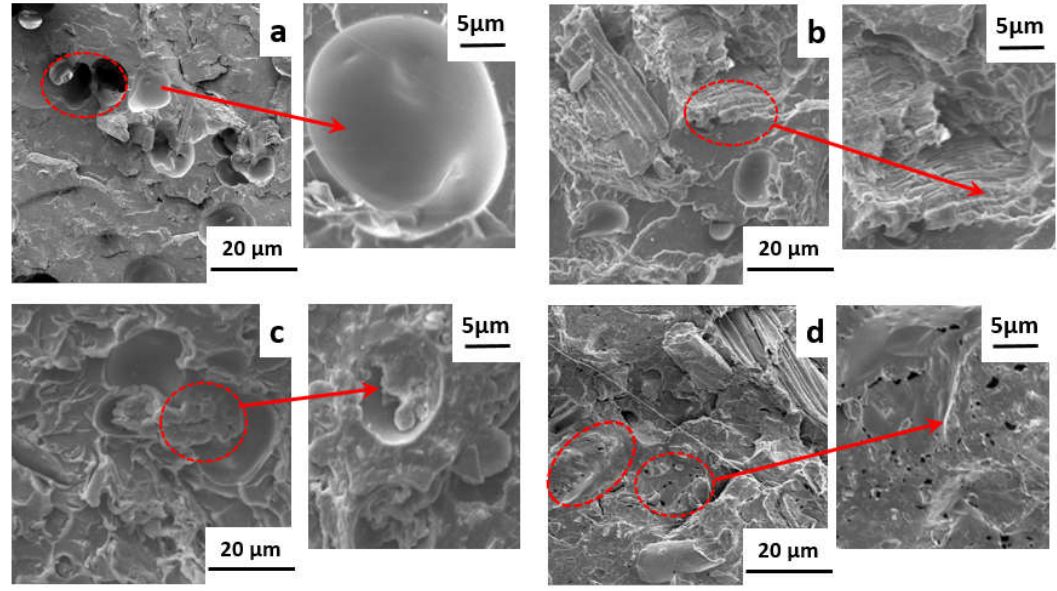
Figure 5. SEM morphology of impact-fracture surface for PLA-based NPCs: ( a ) NPC0; ( b ) NPC1; ( c ) NPC2; ( d ) NPC3.